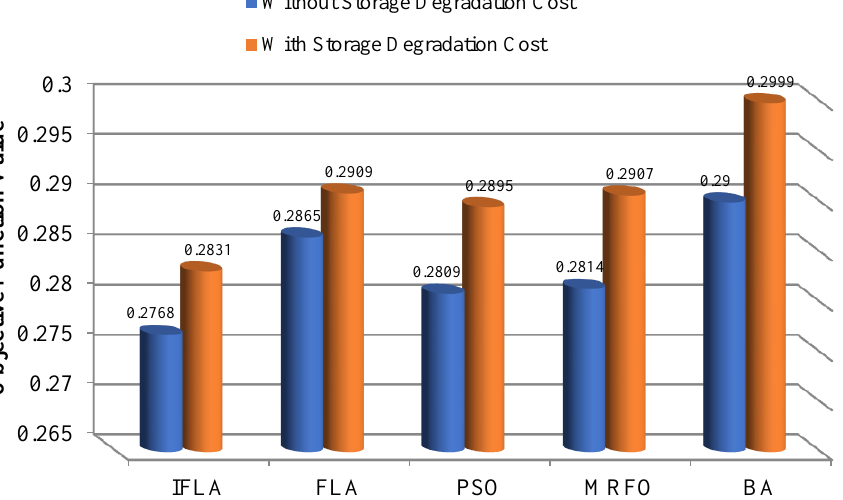
Figure 9. Value of objective function using different algorithms without and with storage degrada- tion cost.